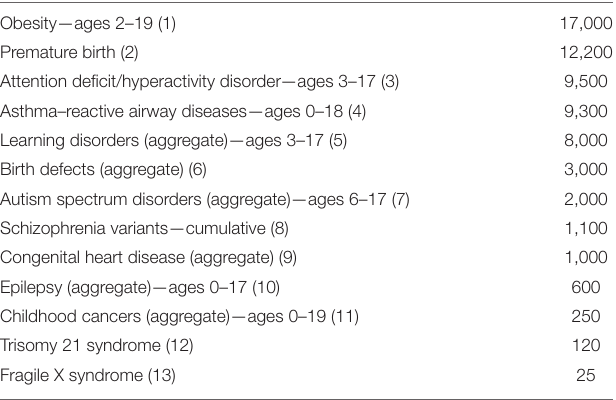
TABLE 1 | Prevalence estimates per 100,000 for selected childhood illnesses or medical conditions * .